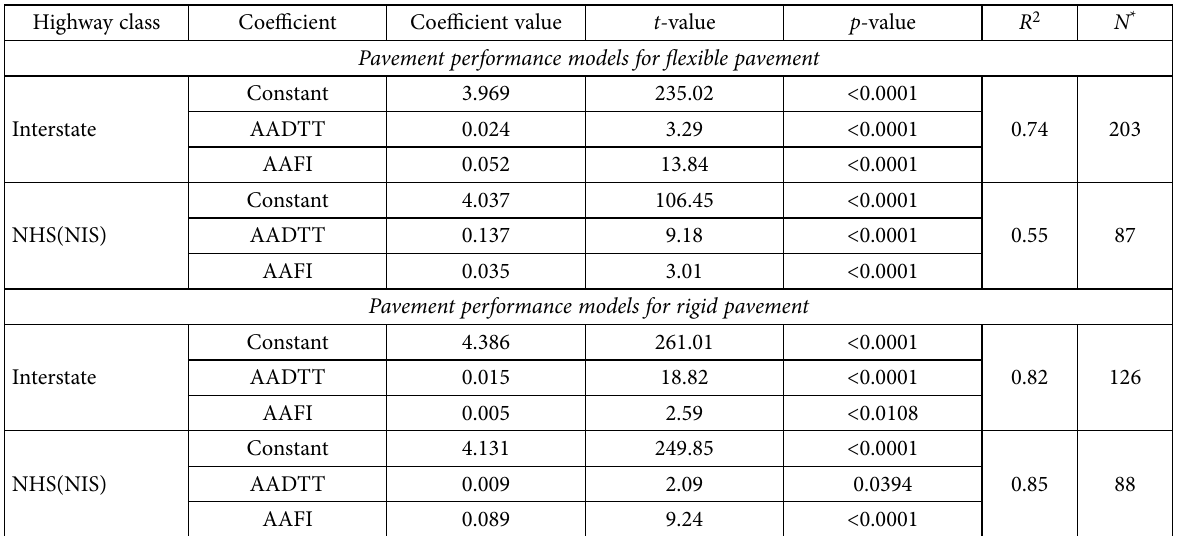
Table 2. Pavement performance